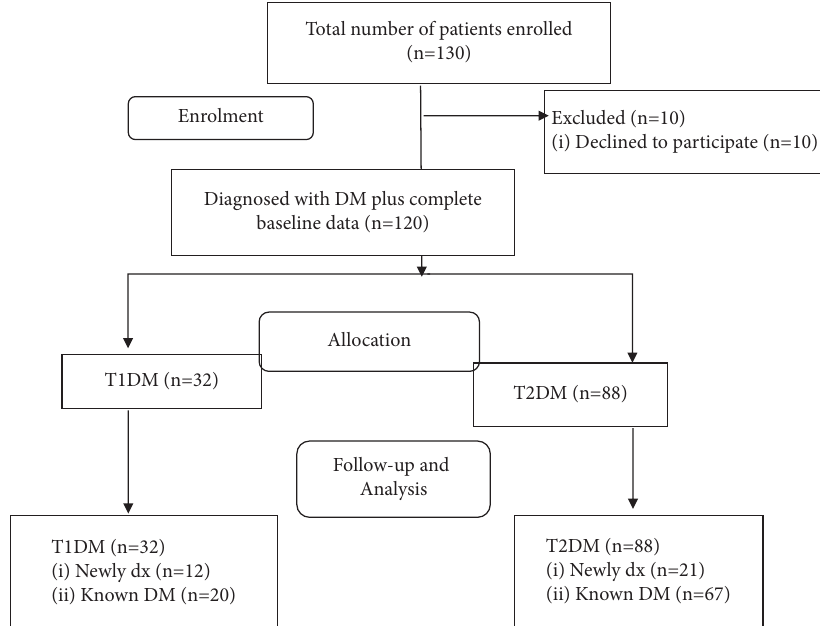
Figure 1: Study fow diagram among patients with DM admitted to JMC from October 01, 2020, to June 30, 2021. Table 1: Sociodemographic characteristics of DM patients admitted to JMC from October 01, 2020, to June 30, 2021.